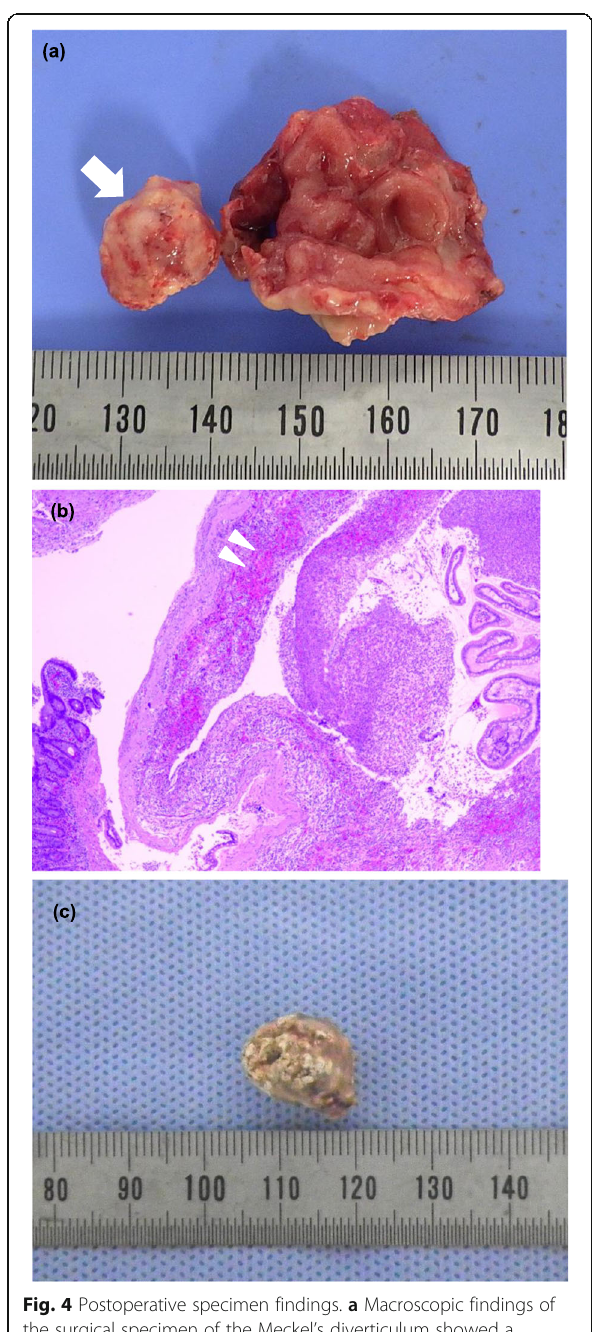
Fig. 4 Postoperative specimen findings. a Macroscopic findings of the surgical specimen of the Meckel ’ s diverticulum showed a narrow-necked diverticulum containing one enterolith (arrow). b